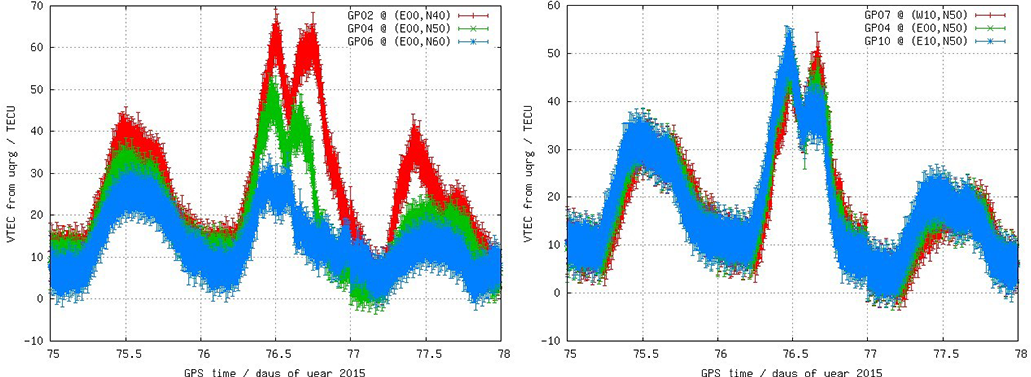
Figure 14. VTEC time series derived from UQRG 15min GIMs for the days surrounding the St. Patrick’s Day storm (including the previous and next days) for the grid points at 0 ◦ longitude (left-hand plot), with latitudes of 40, 50 and 60 ◦ (red, green and blue points) and for the grid points at 50 ◦ latitude (with longitudes of − 10, 0 and + 10 ◦